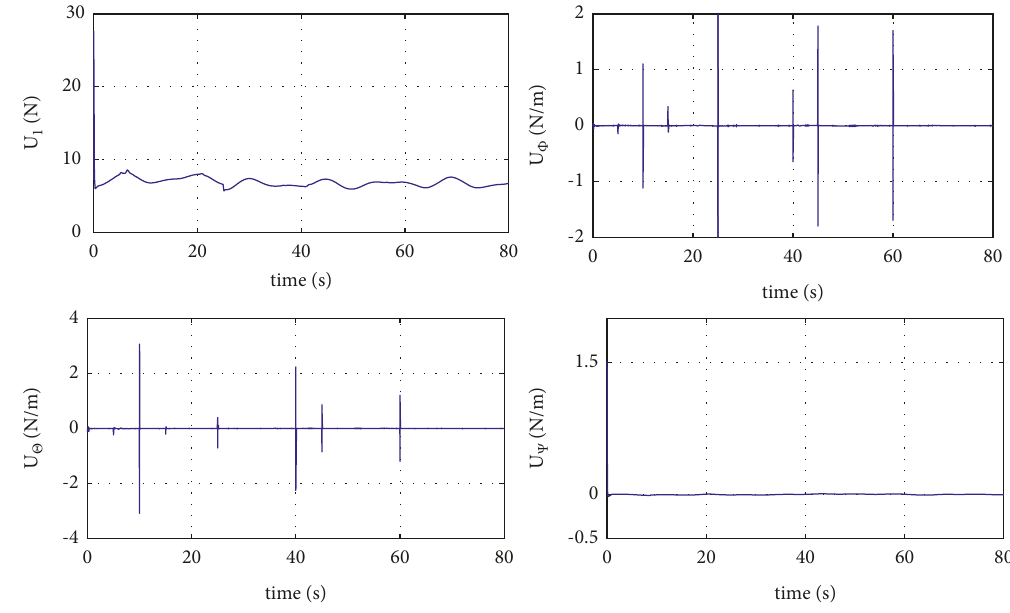
Figure 7: Control effort and torques.